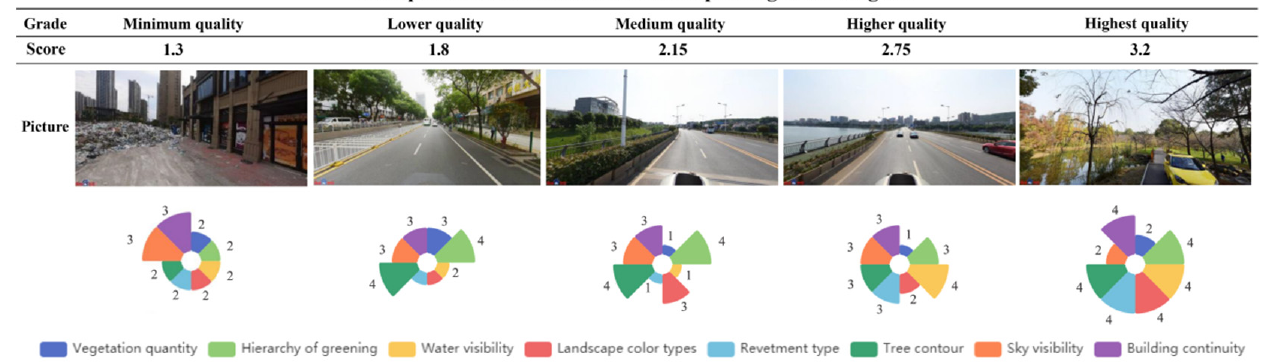
Figure 7. Flowchart of calculating emotion value of word combination.